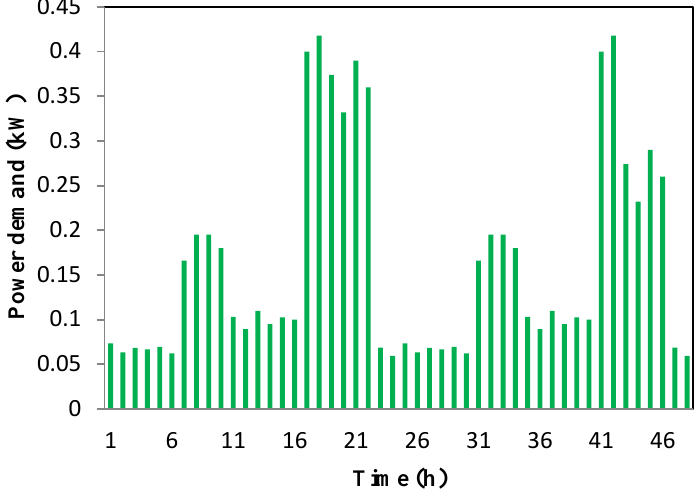
Figure 6. Predicted load profile of a house during mid-peak hours over a 48 h period.